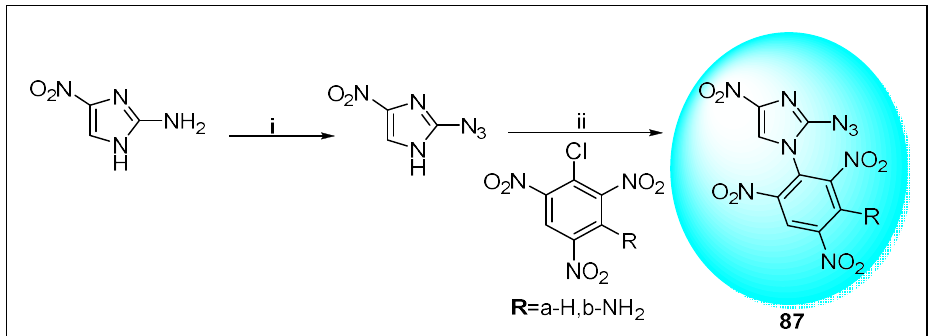
Scheme 27. Synthesis of 2-azido-4-nitroimidazoles. Reagents and conditions: ( i ) NaNO 2 , NaN 3 , H 2 O, H 2 SO 4 , 78%; ( ii ) KHCO 3 , TBAB, IPA, 6 h, 85 °C, 72% and 76%